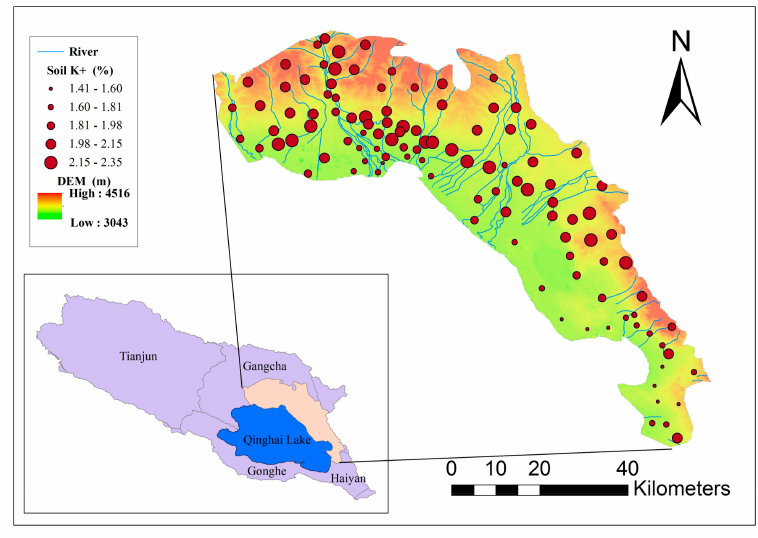
Figure 1. Location of the study area, showing sample sites (circles) and elevation (shading).